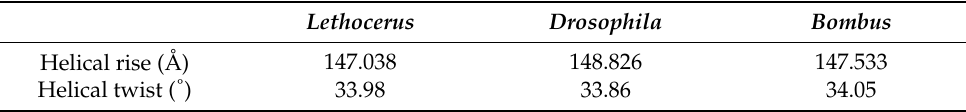
Table 1. The comparison of the helical parameters between three species.